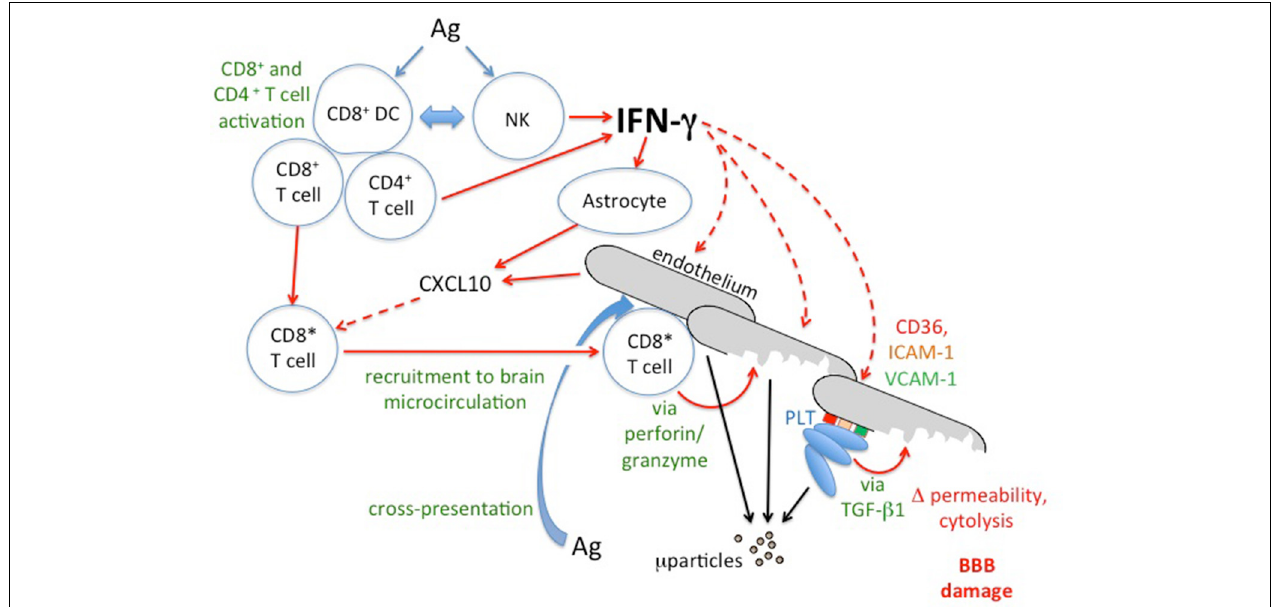
FIGURE 9 | IFN- γ and the immunopathology of cerebral malaria. Schematic based on intervention studies in experimental cerebral malaria. For discussion of possible relevance to human cerebral malaria see text. Solid lines indicate direct actions (e.g., release of IFN- γ ) or transitions (e.g., activation of CD8 + T cells to CD8 ∗ ), broken lines